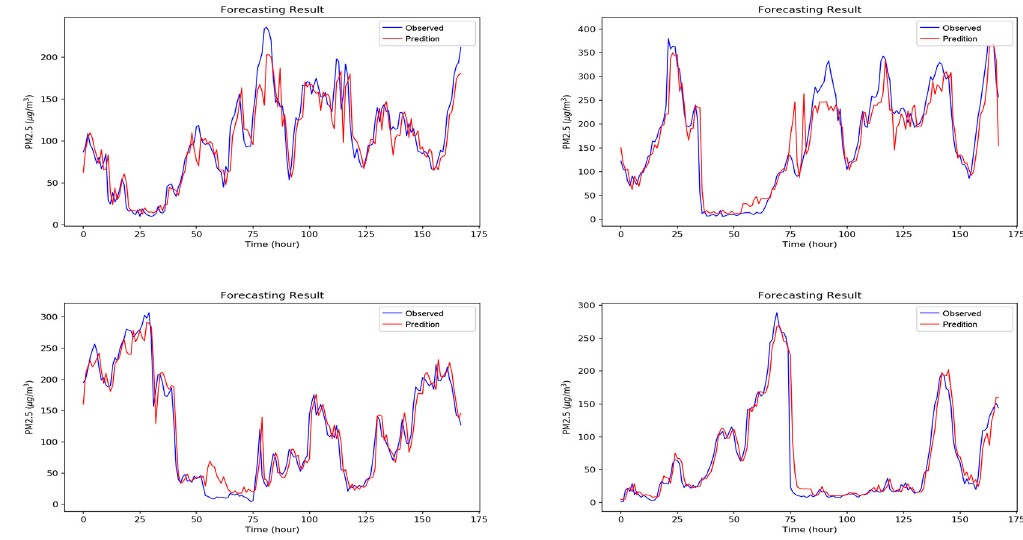
Figure A2. The forecasting results of random forest.